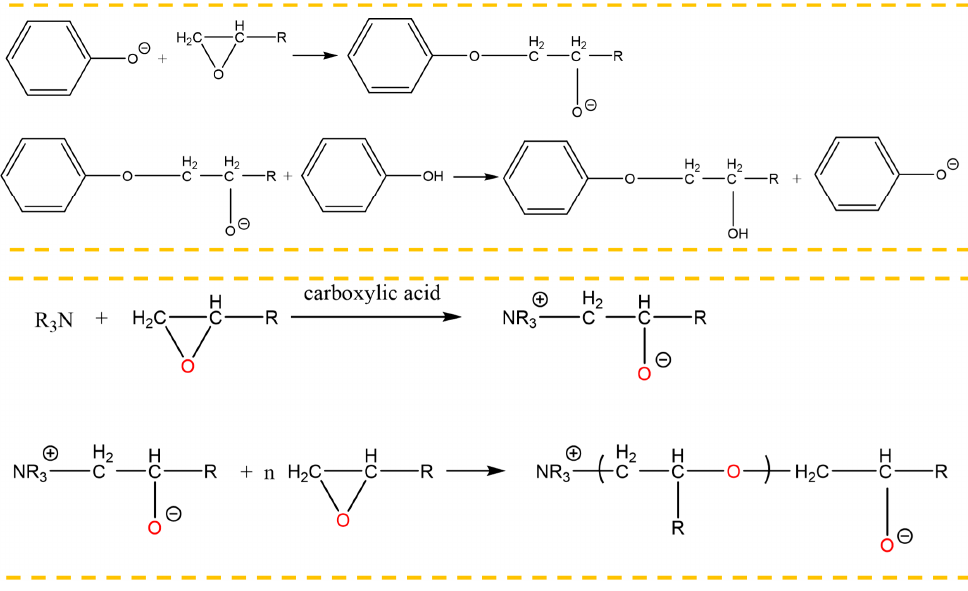
Figure 14. Reaction of the primary amine with the epoxy group on the surface of the grafted Al alloy.